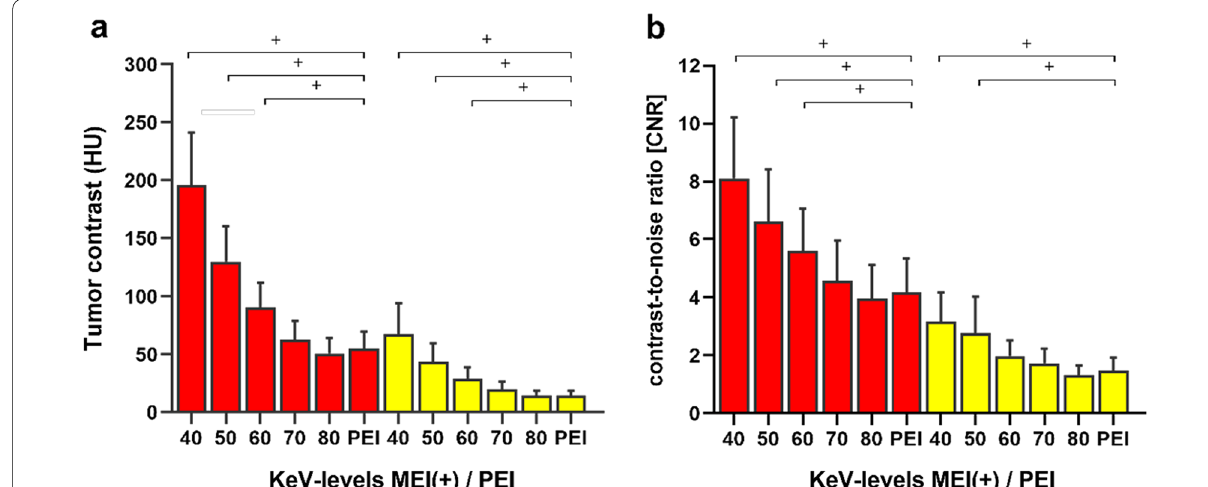
Fig. 2 Bar graph showing the tumor contrast ( a ) and contrast‑to‑noise ratio (CNR) ( b ) between tumor and normal parenchyma in the visually hypoattenuating (red bars) and isoattenuating (yellow bars) pancreatic ductal adenocarcinoma (PDAC). + MEI ( characteristics ( p <